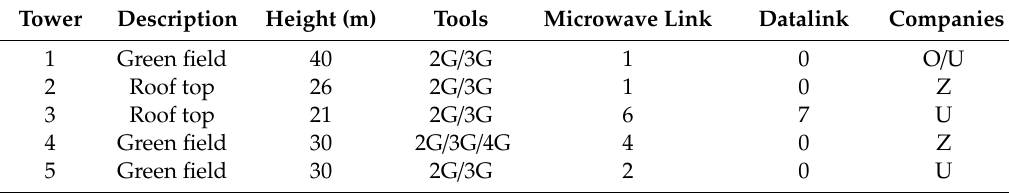
Figure 3. Contour map (elevation surface) of the tested area using geographic information system (GIS) software. The gradient gray color represents the elevation (in meter) from the sea level. The dark circles are the cell phone towers. Table 1. Basic information about cellular towers in the tested area. The assignment of the towers is in Figure 1.